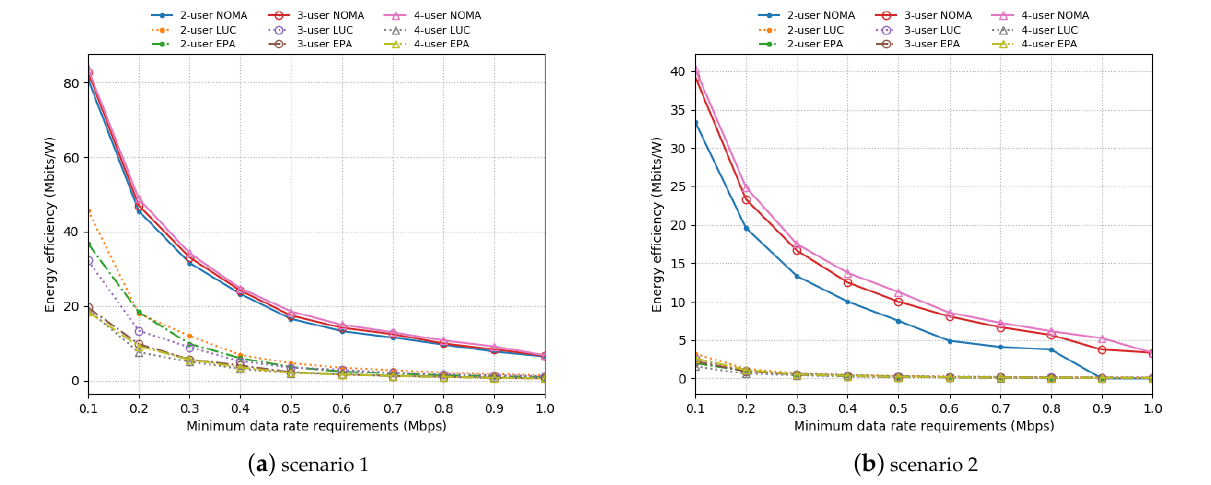
Figure 7. Energy efficiency versus minimum data transmission rate requirements of each user for our proposed algorithm, location-based user clustering strategy, and equal power allocation